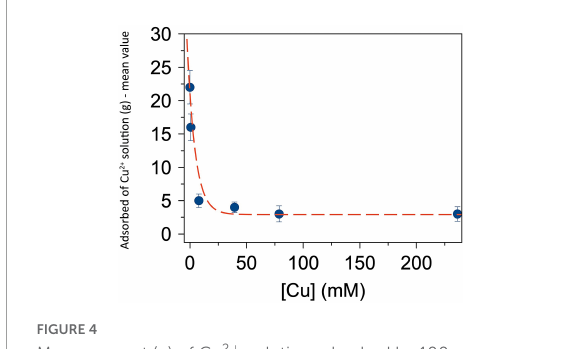
FIGURE4 Mean amount (g) of Cu 2 + solution adsorbed by 100 mg super absorbent polymer (SAP) on the respective value of Cu 2 + concentration (mM) in the same solution used for producing the super absorbent polymer containing copper (SAP-Cu). The red dotted line helps the reader’s eye. Bars represents standard deviation